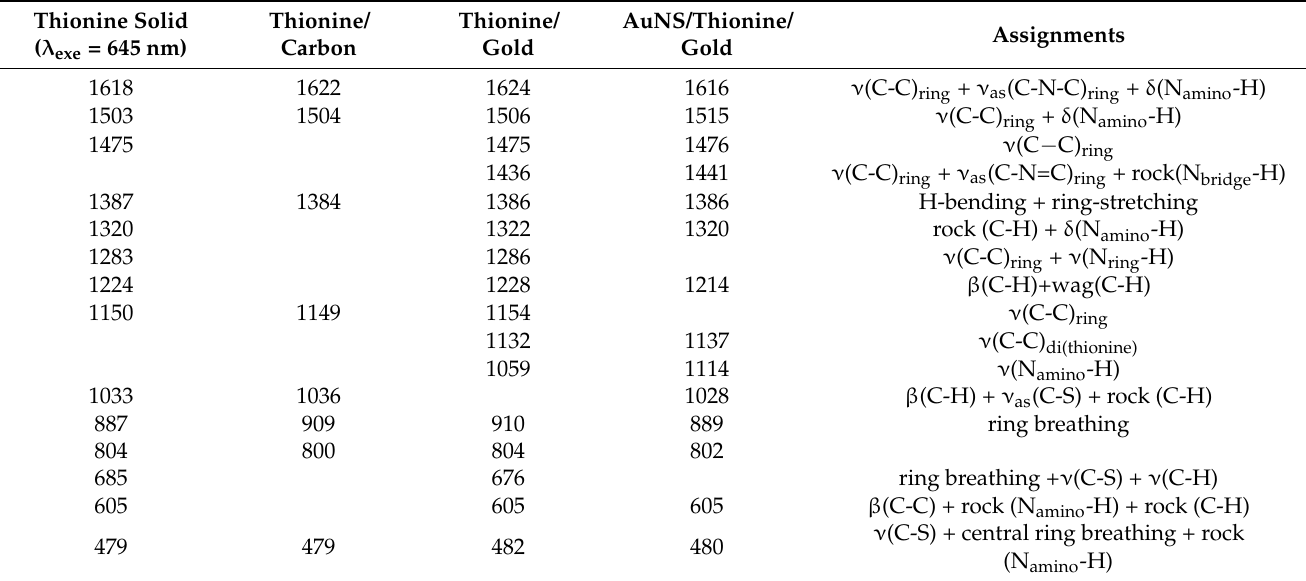
Table 1. Raman bands of a TH solution on carbon or gold substrate assigning its presence and TH